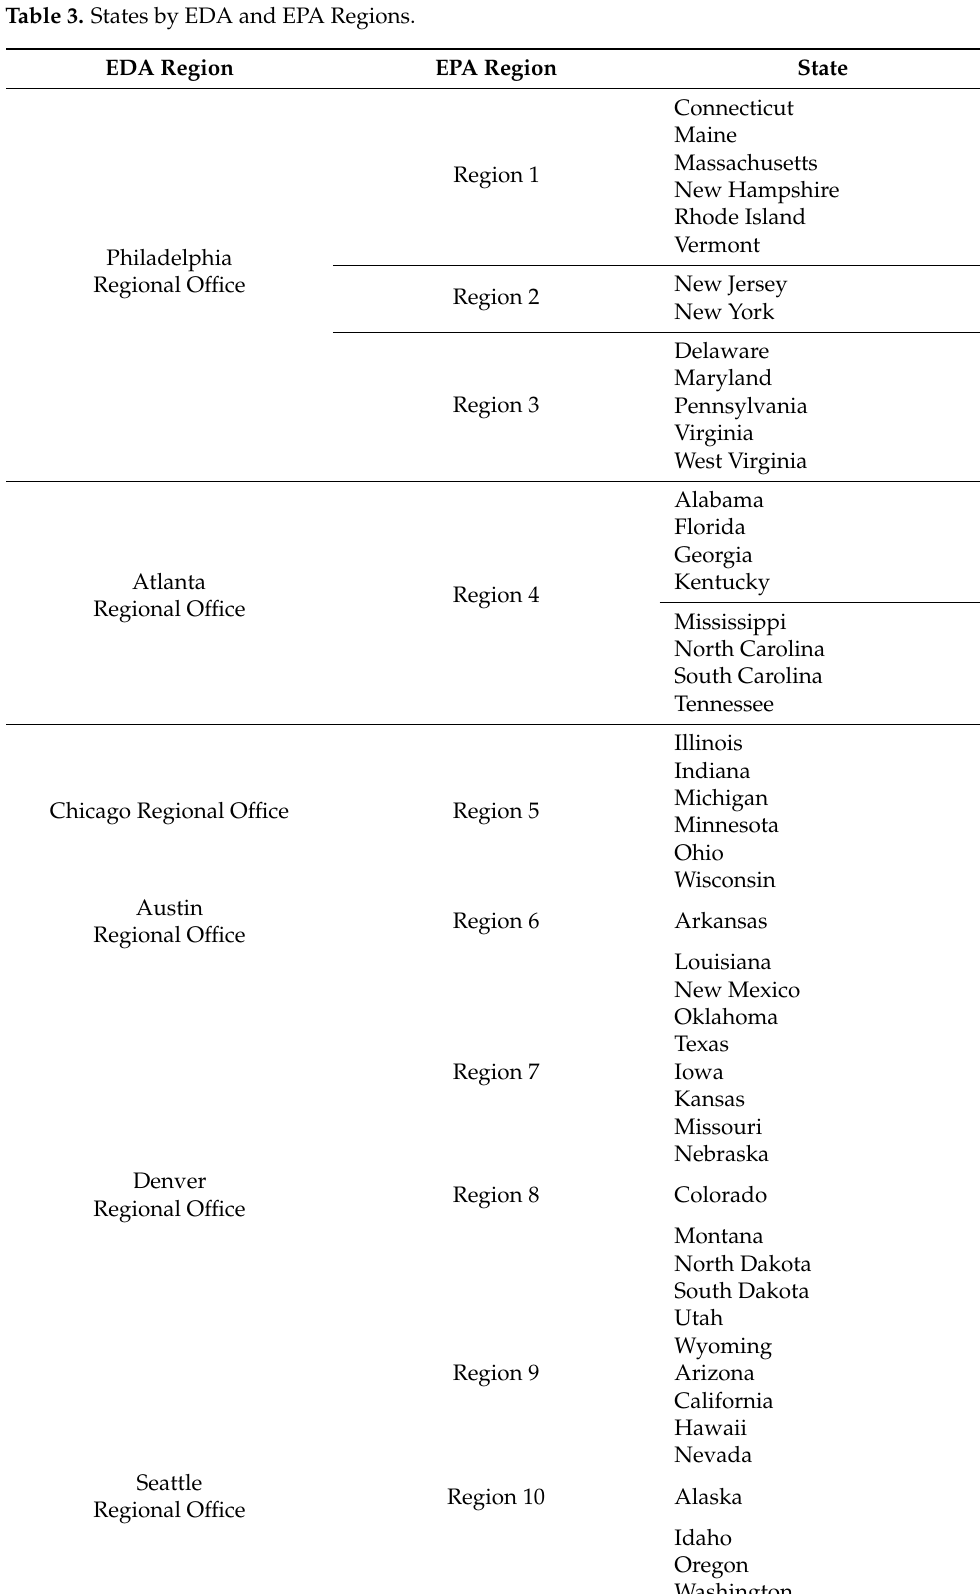
Table 3. States by EDA and EPA